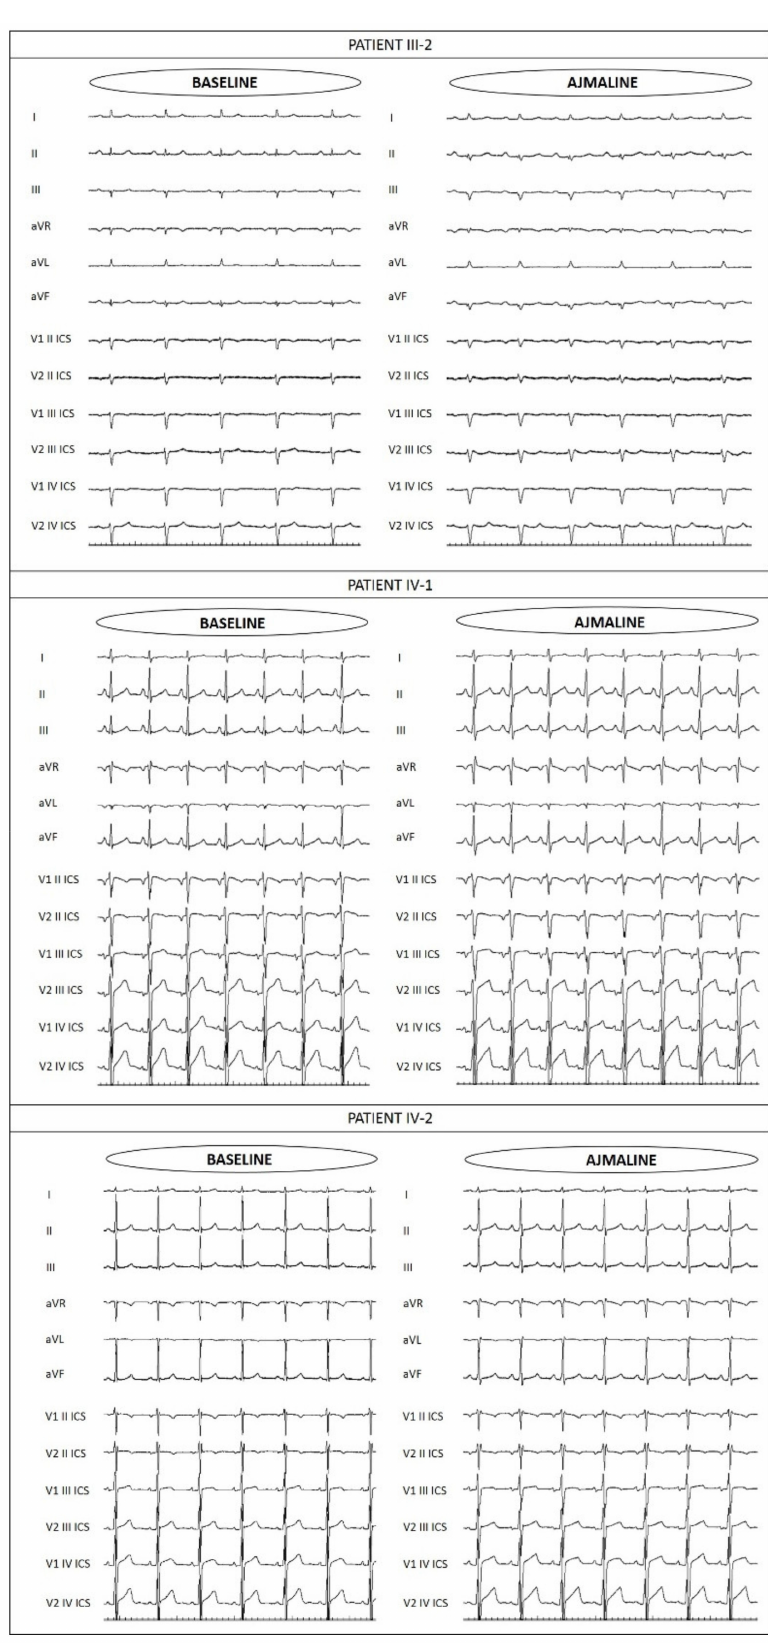
Figure 4. Electrocardiograms before and after ajmaline administration, demonstrating that these family members were negative for BrS, due to the lack of the development of a type 1 BrS ECG